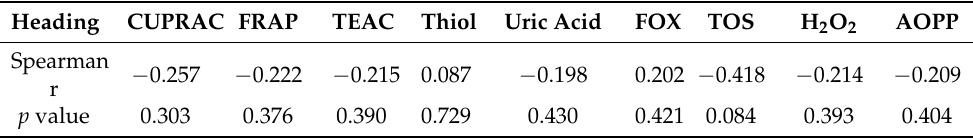
Table 1. Spearman correlation coefficients and significance between the magnitude of change of the different analytes before and after vaccination and antibody titers studied in serum cattle vaccinated with